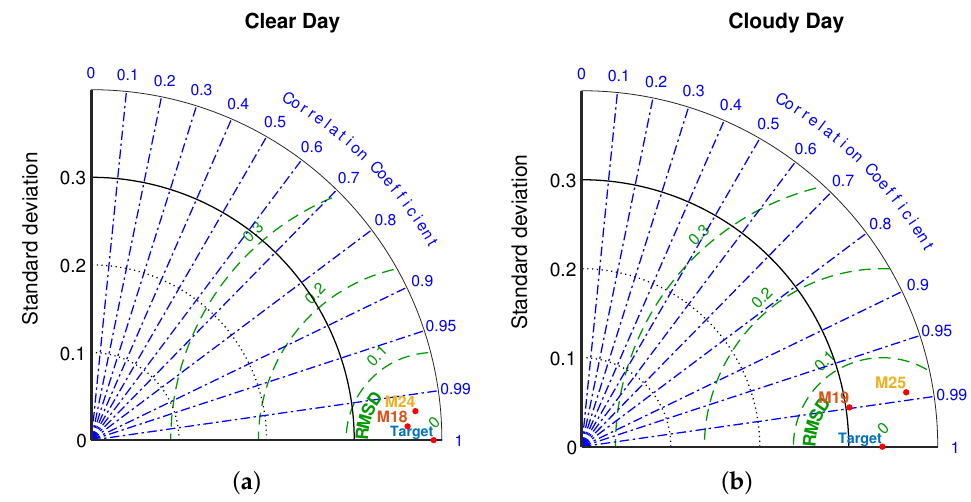
Figure 11. Comparison of clear and cloudy days when time steps = 15: ( a ) Clear sky. ( b ) Cloudy sky.